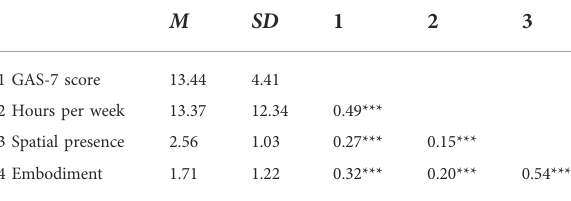
TABLE 1 Means, standard deviations, and Pearson zero-order correlations between the quantitative variables collected in the